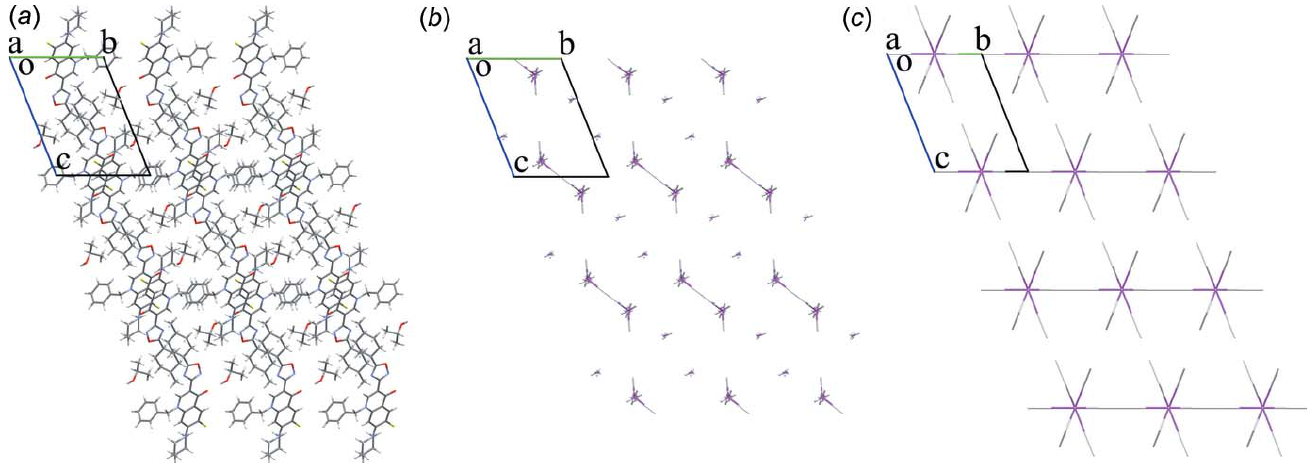
Figure 7 Crystal packing of the molecules ( a ) and energy vector diagrams of the molecules and tetramers as building units, ( b ) and ( c ), respectively, for position A . Projection in the direction [100].